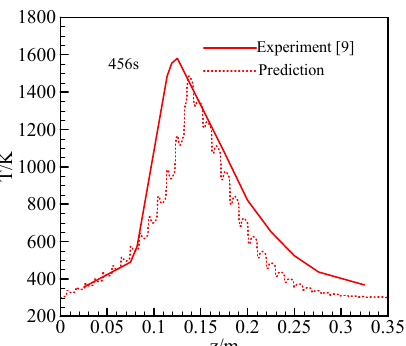
Figure 4. The prediction of combustion wave for ϕ = 0.15 , u g = 0.43 m/s at t = 456 s.